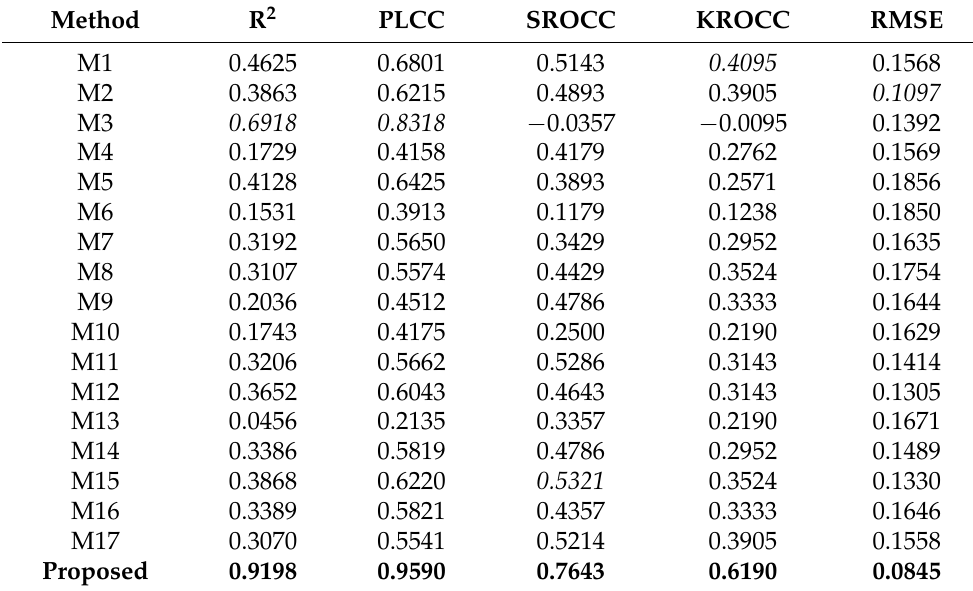
Table 3. Performance of the proposed and the compared methods on the whole test dataset. The best results are marked in bold and the second-best in